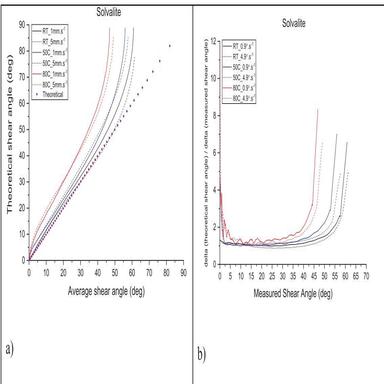
Theoretical and measured shear angles from BE for CEP-TW1 prepreg; a) a direct comparison, and b) slope of 'theoretical to experimental' versus measured shear angles (experimental).